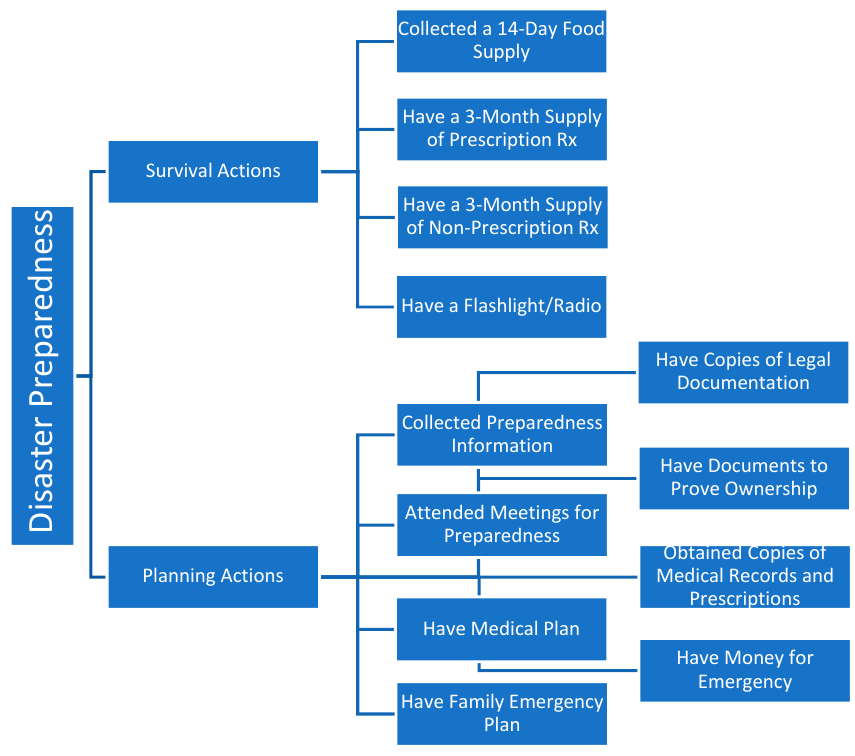
Figure 1. Classification of Disaster Preparedness Activities into Survival and Planning Preparedness